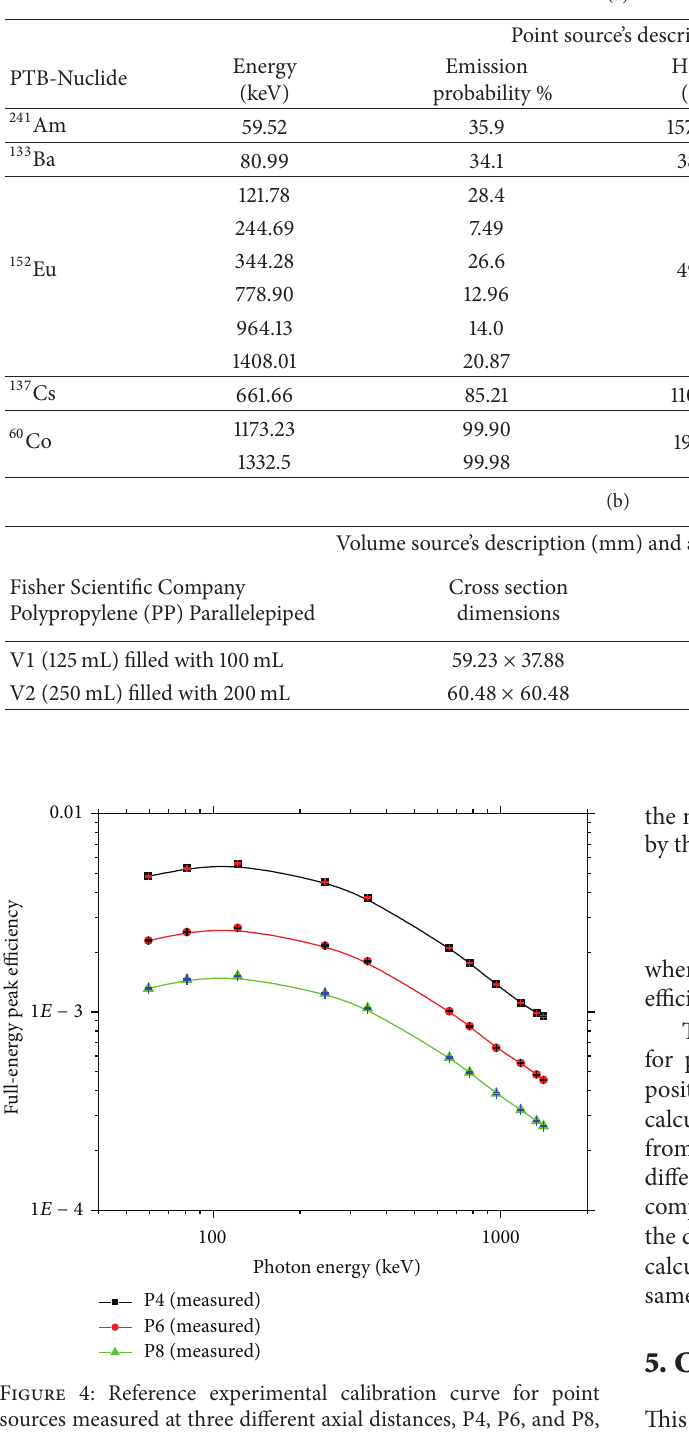
Table 5: The point and volume source’s description.